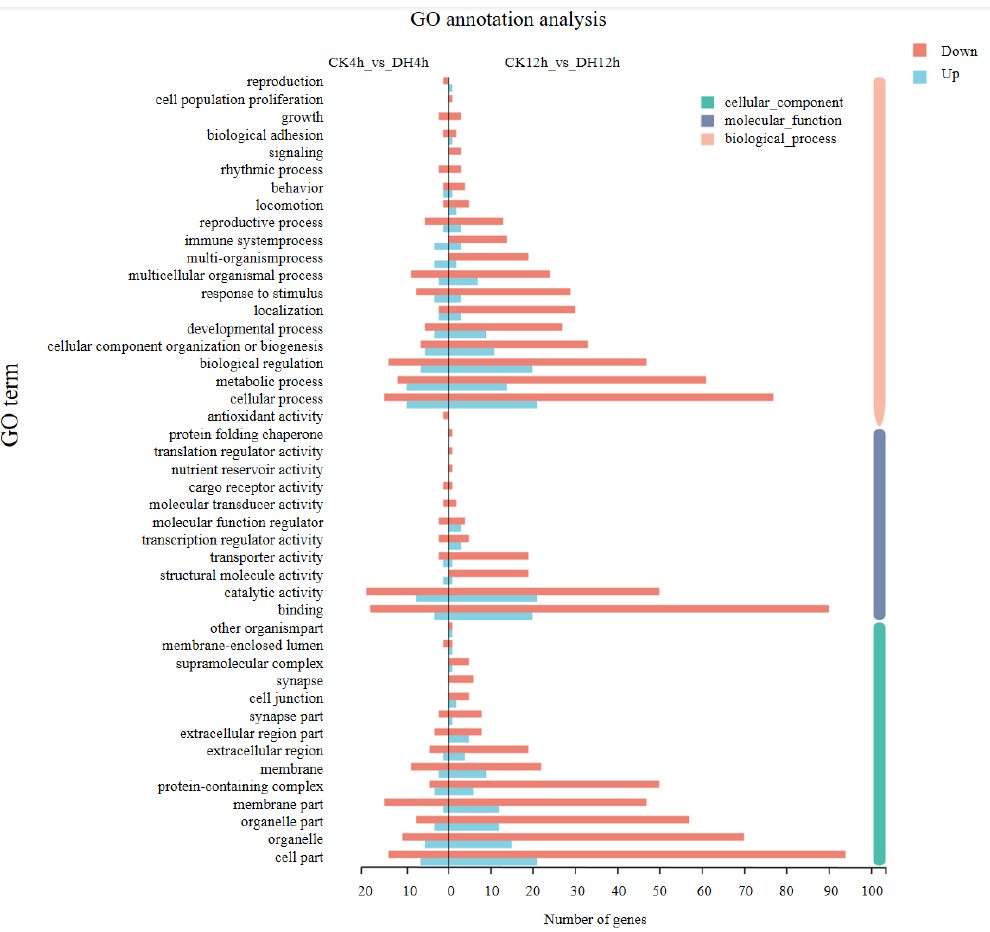
Figure 4. GO annotation analysis of DEGs in CK4h_vs._DH4h group and CK12h_vs._DH12h group. The vertical axis represents number of DGEs mapped to indicated GO term, and the horizontal axis represents each GO term. Red and blue bars represent up-regulated and down-regulated genes, respectively.